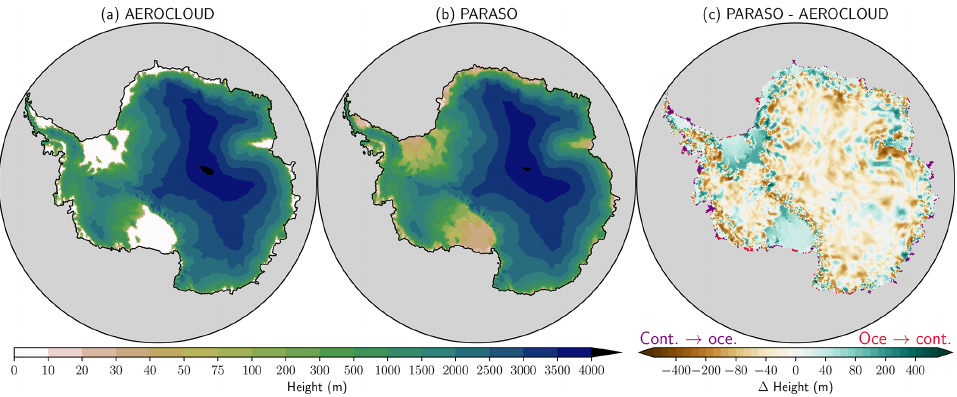
Figure 5. Surface elevation for (a) a previous CCLM 2 stand-alone model configuration (AEROCLOUD), (b) PARASO and (c) their absolute difference (PARASO–AEROCLOUD). Note that all color scales are nonlinear. In panel (c) , nodes that change nature, from AEROCLOUD land to PARASO ocean (AEROCLOUD ocean to PARASO land), are displayed with purple (red) shadings.